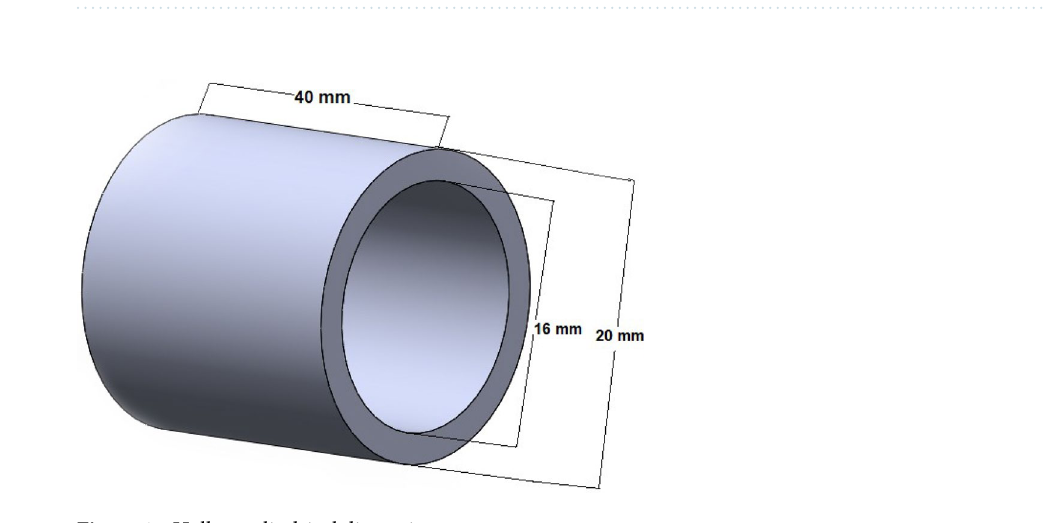
Figure 1. Hollow cylindrical